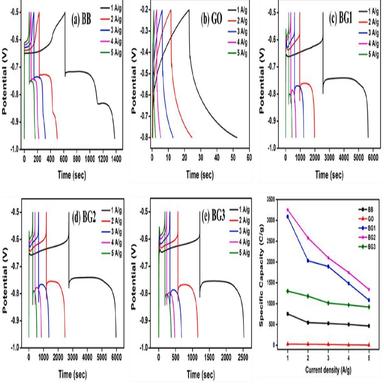
GCD profile of (a) BB, (b) GO, (c) BG1, (d) BG2, (e) BG3 and (f) their specific capacity at different current density.